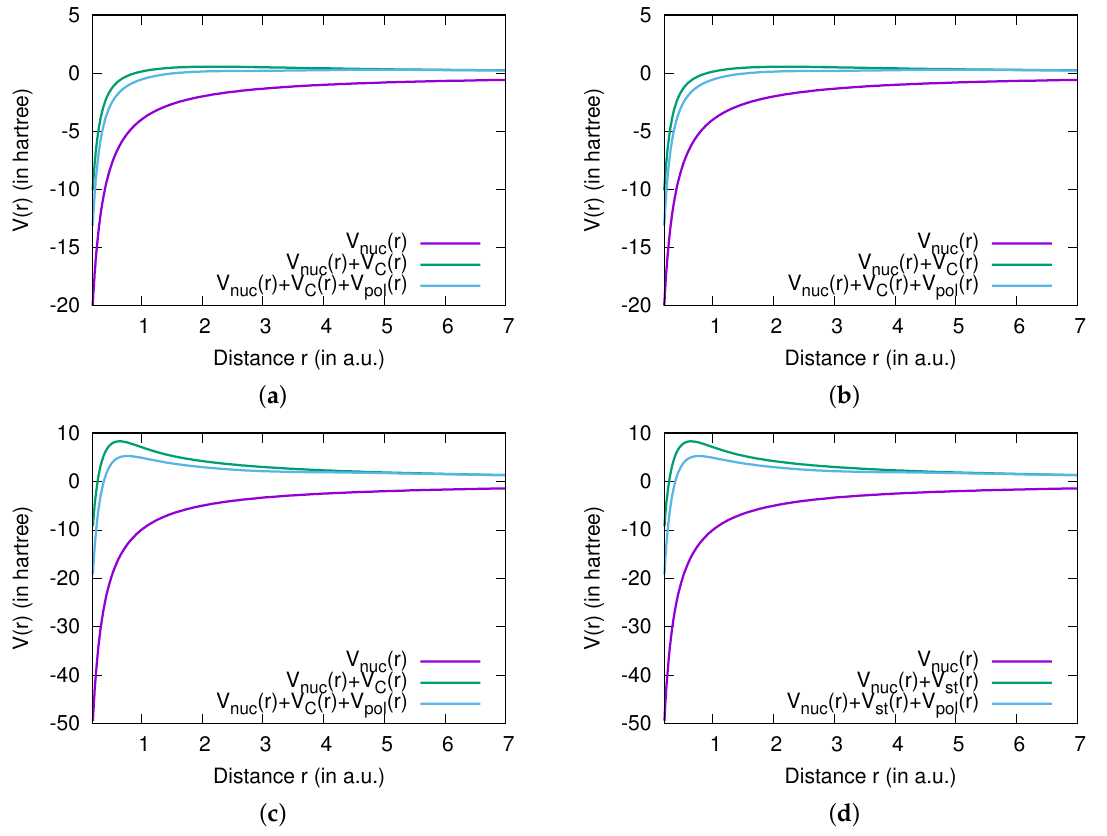
Figure 3. Plots demonstrating comparative analyses of contributions from V nuc ( r ) , V C ( r ) and V pol ( r ) to the electron scattering potential V ( r ) from the Be and Mg alkaline-earth atoms. In ( a , b ), results are given from the RCCSD and RNCCSD methods, respectively, for the Be atom. Results from the RCCSD and RNCCSD methods are shown in ( c , d ), respectively, for the Mg atom. All quantities are given in